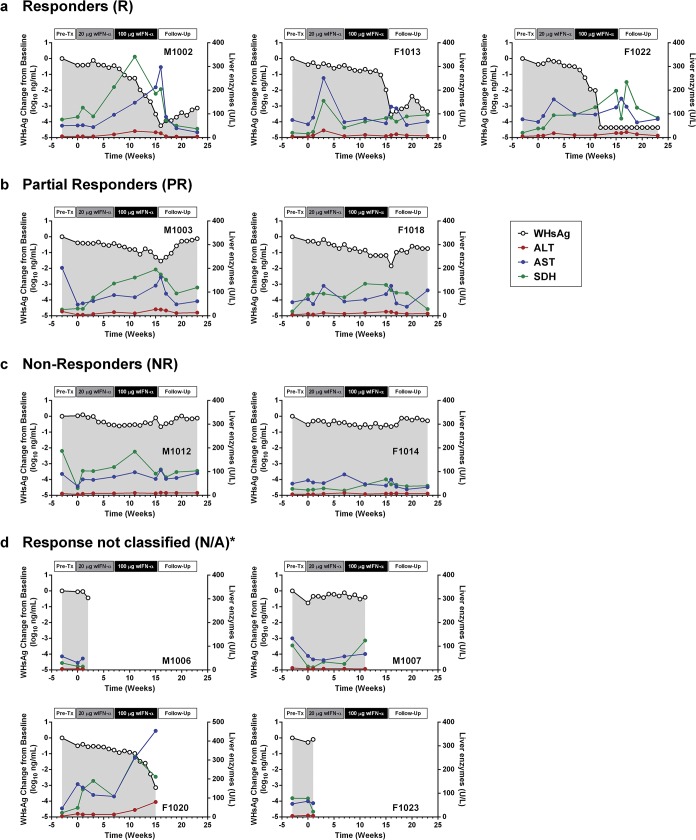
Serum WHsAg and liver enzymes for individual wIFN-treated animals.Serum WHsAg (black open circles) is plotted on the left y-axis. Serum ALT (red circles), AST (blue circles) and SDH (green circles) are all plotted on the right y-axis. The treatment response group classifications (a-d) are described in Table 1. *Animals died prior to end-of-study. Note all data was from pre-dose (or equivalent).